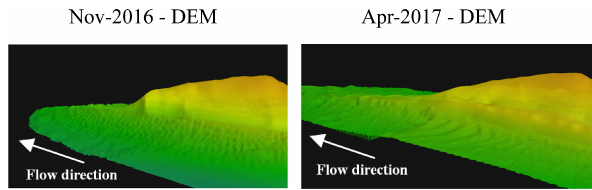
Figure 4. Small bed features (sand dunes) were mapped on the bot- tom of the river using ADCP repeated transects acquired at different stages of the hydrological